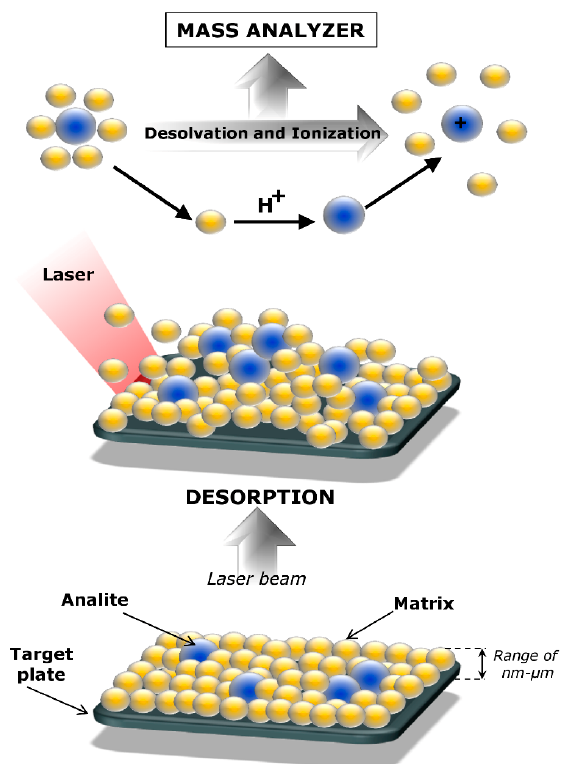
Figure 1. Ionization and desorption processes in matrix-assisted laser desorption/ionization (MALDI).